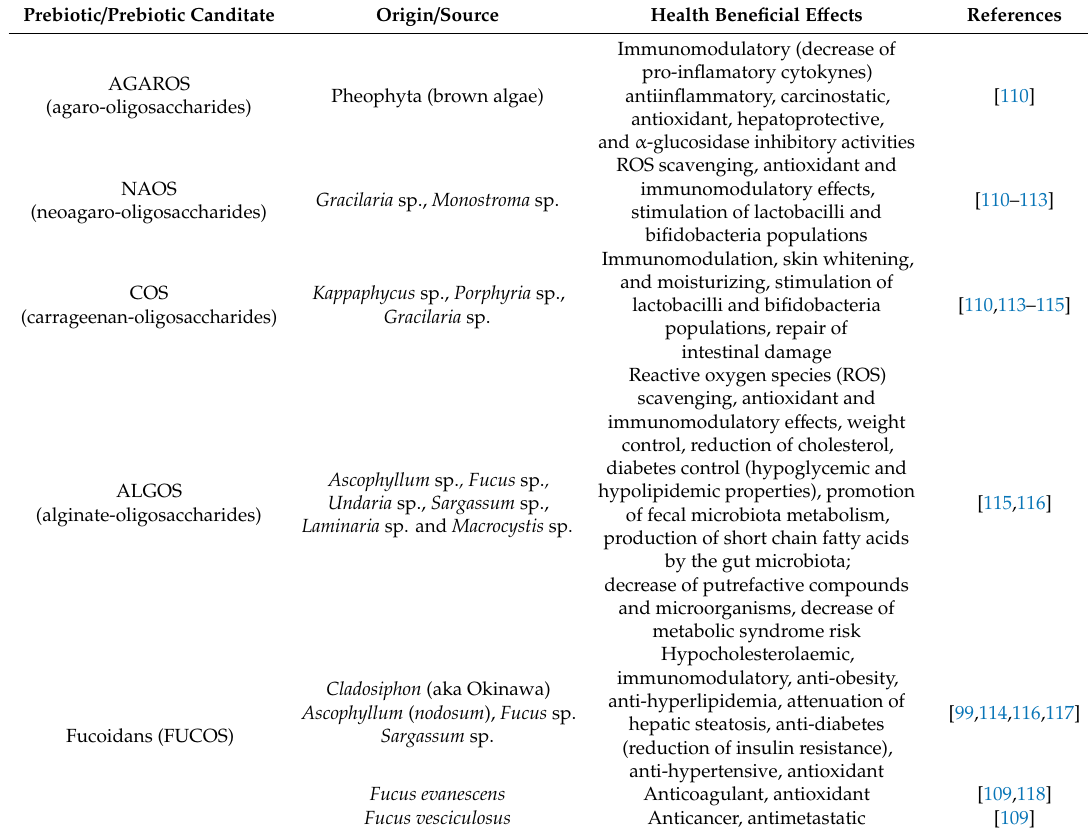
Table 5. Prebiotic or prebiotic candidates extracted from marine